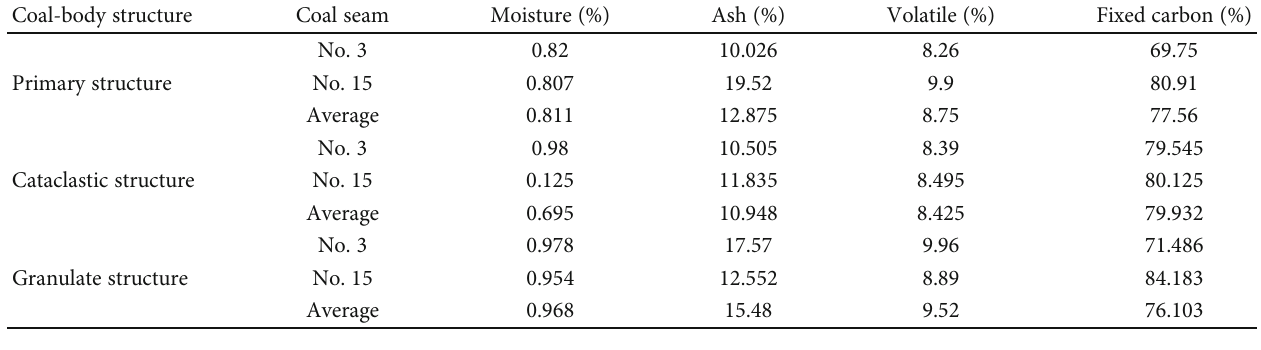
Table 5: Coal quality parameters of No. 3 and No. 15 coal seams in the Mabidong block (air-dried basis).